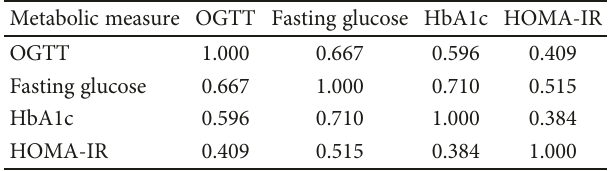
Table 1: Correlations among the glucose metabolism